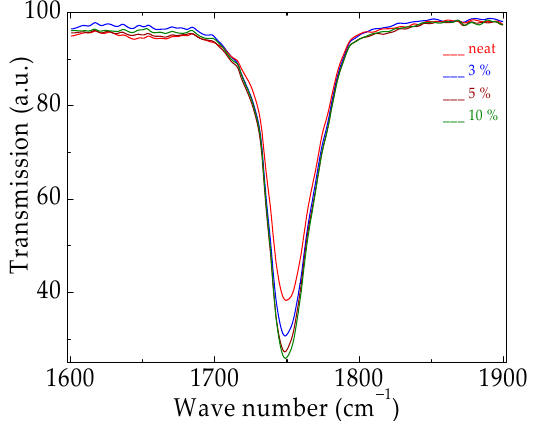
Figure 9. The FTIR spectra recorded on the PLA/SIS 30 modified with nanoparticles of silica after their exposure to a γ dose of 50 kGy.